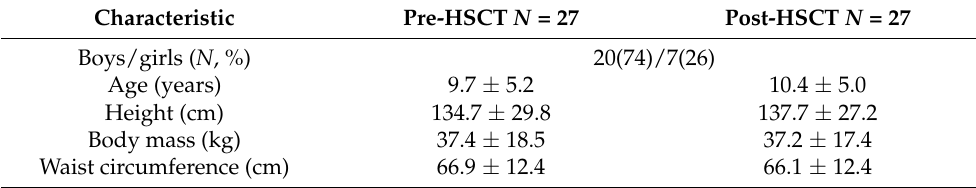
Table 4. Characteristics of children treated with